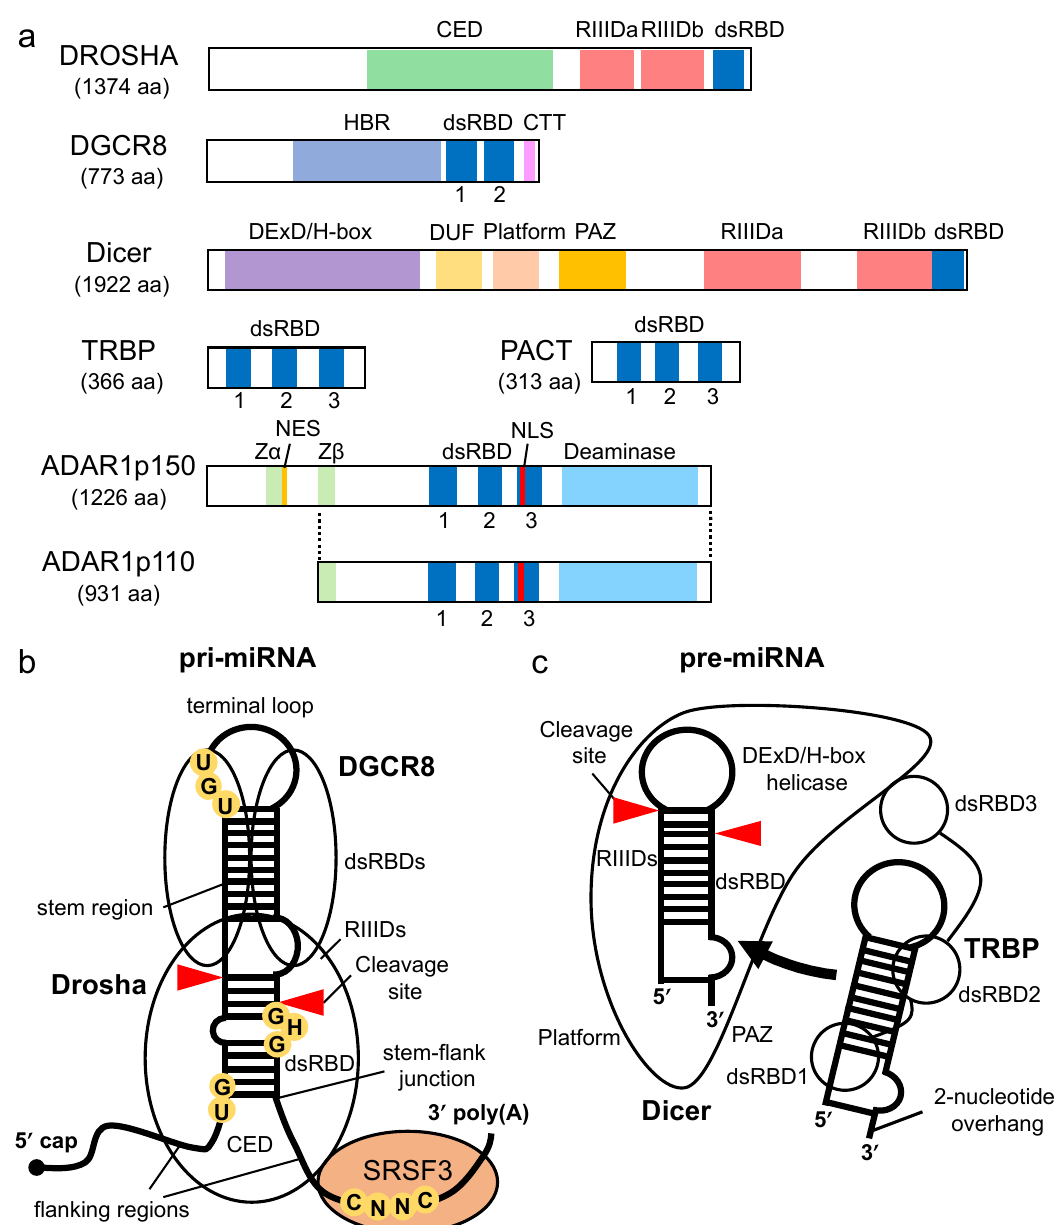
Figure 2. Domain structure of proteins involved in miRNA biogenesis and structural features of processing complexes of pri-miRNA and pre-miRNA. ( a ) The domain structures of Drosha, DGCR8, Dicer, TRBP, PACT, ADAR1p150, and ADAR1p110. CED indicates central domain; RIIIDa, RNase III domain a; RIIIDb, RNase III domain b; dsRBD, double-stranded RNA binding domain; HBR, heme-binding region; DExD/H-box, DExD/H-box helicase; CTT, C-terminal tail; DUF283, domain of unknown function; PAZ, Piwi–Argonaute–Zwille; Z α and Z β , Z-DNA binding domain α and β , respectively; NES, nuclear export signal; NLS, nuclear localization signal. ( b ) Pri-miRNA has a terminal loop, stem region, and flanking region as common structural features, and some pri-miRNAs have conserved sequence motifs. UG is recognized by Drosha, UGU is recognized by DGCR8, GHG is recognized by dsRBD of Drosha, and CNNC is recognized by Ser/Arg-rich splicing factor 3 (SRSF3). ( c ) Pre-miRNA is structurally characterized by a terminal loop, a stem region, and a 3 ′ end